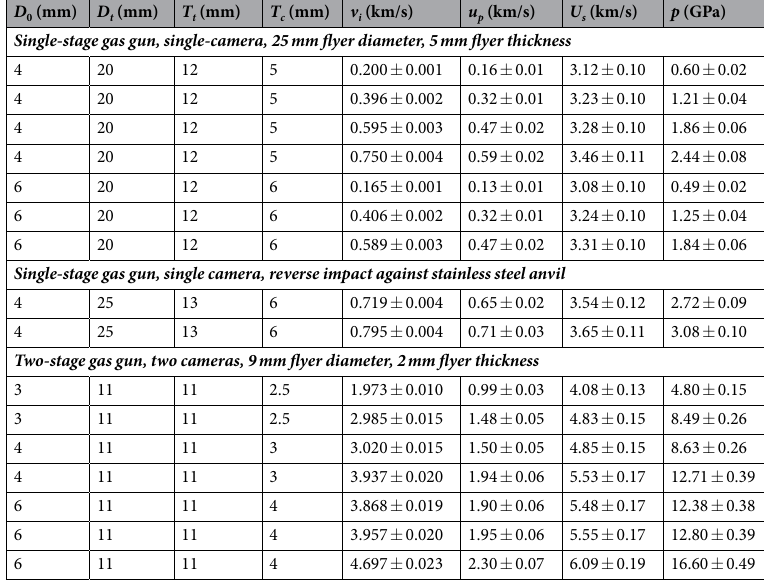
Table 2. Details of the results and the three setups used for the experiments. The values for u p , U s and p were calculated using Eq. 1 and the impedance matching